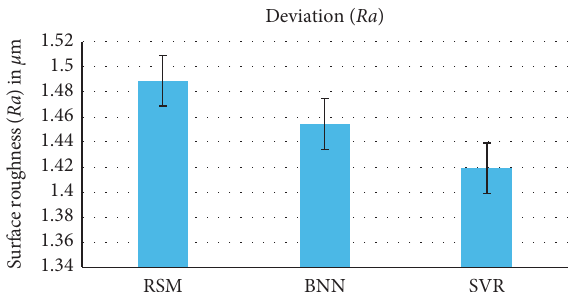
Figure 13: The predicted Ra deviation comparison among RA, BNN, and